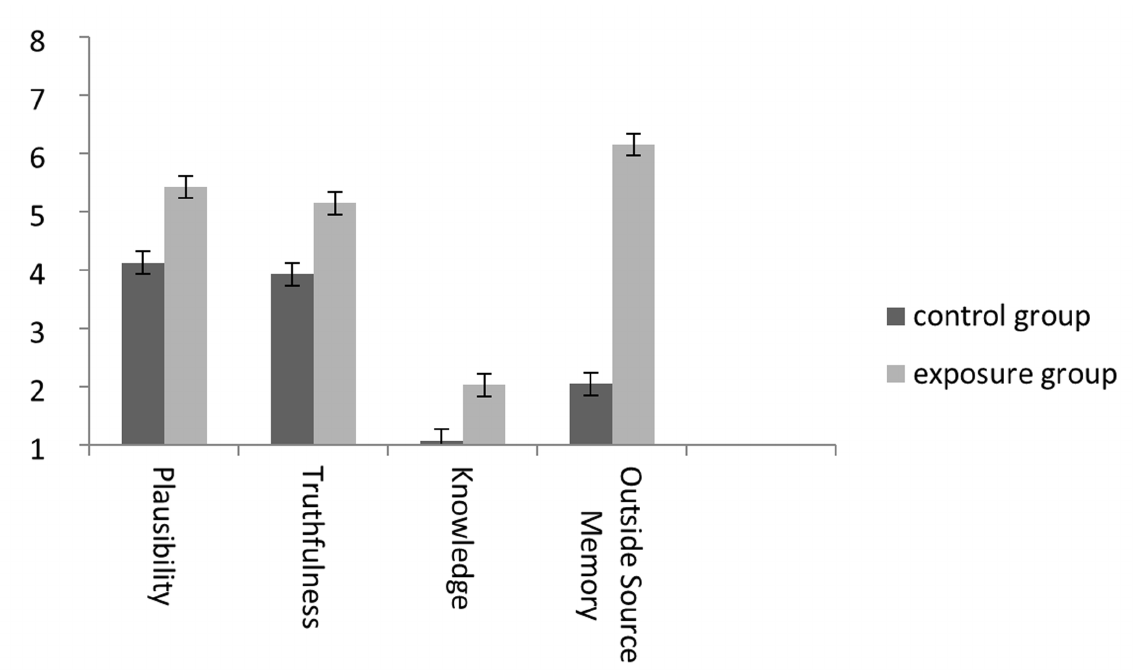
Average false story ratings of plausibility, knowledge, truthfulness, and memory for outside source given by the control and previous exposure groups. Likert scale ratings range from 1 (none) to 8